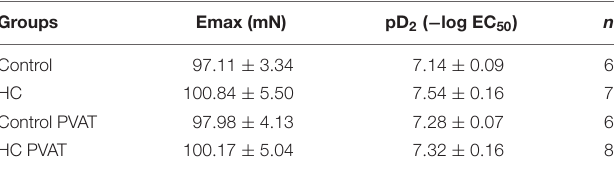
Values represent mean ± SEM. Statistical significance was determined using two- way ANOVA followed by Holm–Sidak’s post hoc